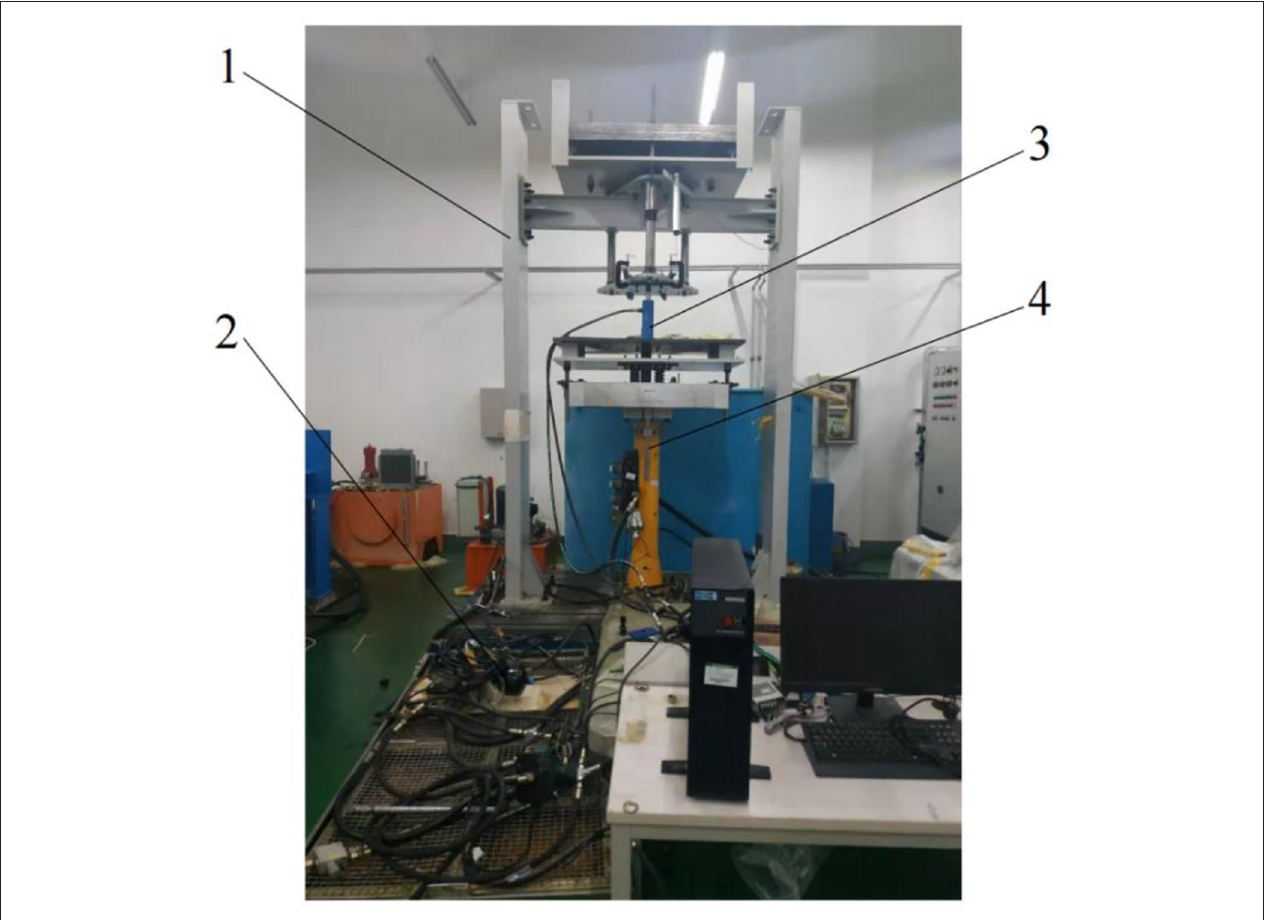
FIGURE 5 | Active hydro-pneumatic suspension test bench. 1. Vibration test bench 2. Accumulator 3. Hydraulic cylinder 4. Exciting hydraulic cylinder.